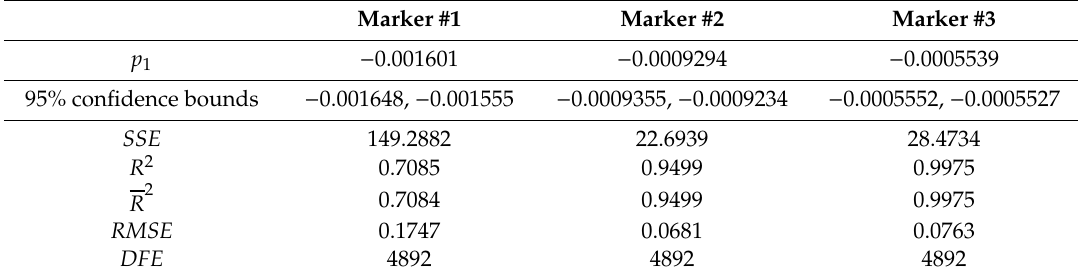
Figure 11. The four markers used in the unloaded configuration; specific features followed frame- by-frame indicated by a red circle. Parabolas fitted over markers #1, #2 and #3 are shown as solid curves in shades of purple. Transverse displacements of marker #0 were too small to successfully fit a parabola on them, but the small motion might be assumed as a straight vertical vibration (dashed red line) with negligible error. Table 5. Goodness-of-fit statistics for parabolas fitted over experimental Table 5. Goodness-of-fit statistics for parabolas fitted over experimental data.